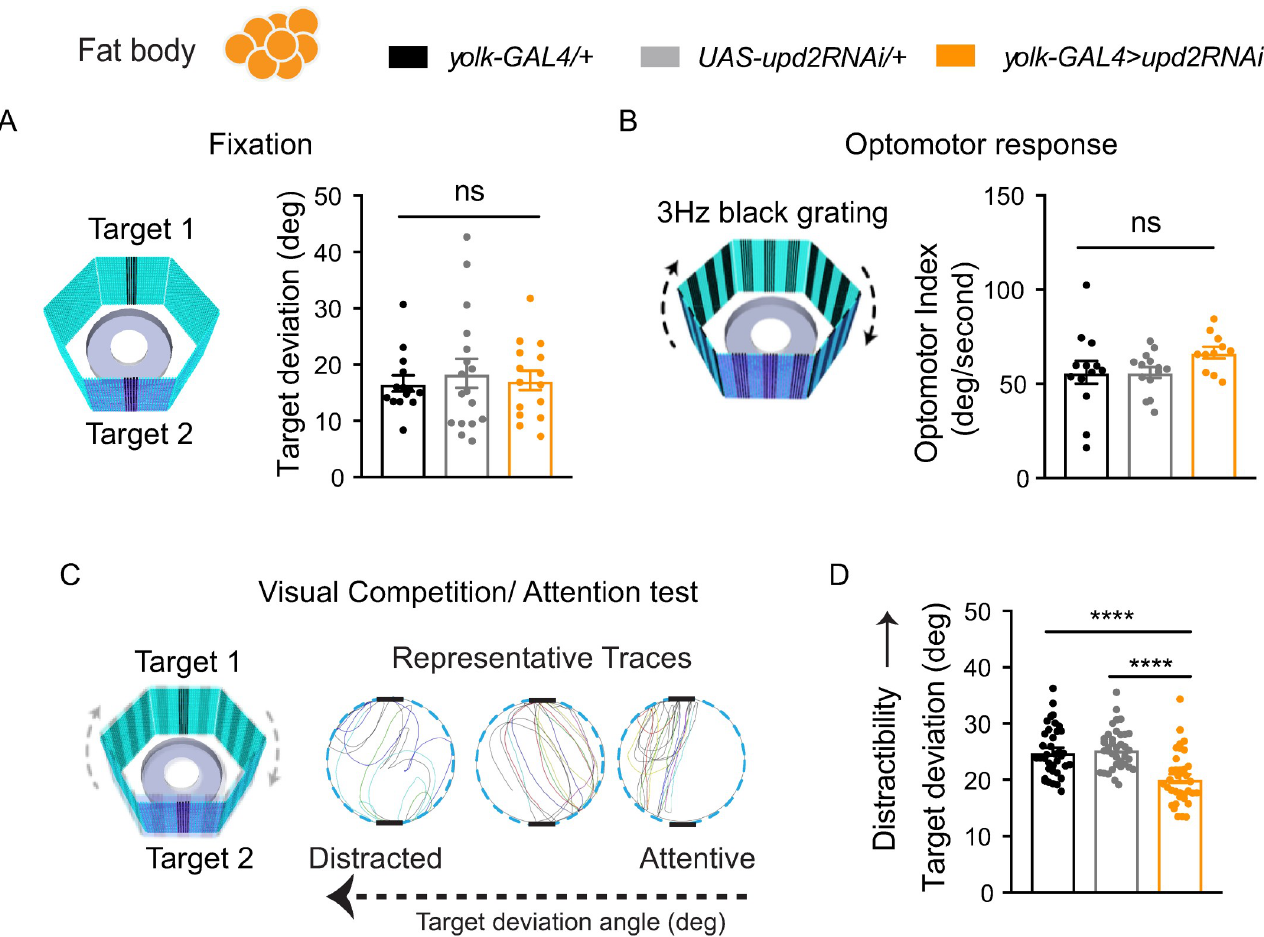
Fig 6. Visual behavior in upd2 deficient flies. (A) Fixation behavior in Buridan’s paradigm, in which flies were presented with two opposing black bars flickering at 7 Hz. Fixation responses were calculated by target deviation in degrees and was nonsignificant between genetic controls (gray and black bars) and knockdown flies (orange bar) ( n = 15). (B) Optomotor response to motion stimulus (3-Hz grating) determined by the fly’s turning angle (degrees per second) for genetic controls (gray and black bars) and knockdown flies (orange bar) ( n = 11). (C) For visual competition (attention) experiments, flies were presented with the two flickering bars (fixation targets) and the 3-Hz grating (distractor) together. The target deviation angle represents a measure of distractibility. Representative traces show the trajectories of single flies with low (right), average (middle), and high (left) target deviation angles. (D) Target deviation for knockdown flies (orange bar) was significantly lower compared with genetic controls, indicating less distractibility ( n = 21). One-way ANOVA with Tukey correction was used for comparing different conditions. � P < 0.05, �� P < 0.01, ��� P < 0.001, ���� P < 0.0001; error bars show SEM. The data underlying this figure can be found in S1 Data. GAL4, galactose-responsive transcription factor; RNAi, RNA interference; UAS, upstream activation sequence; upd2 , unpaired 2.